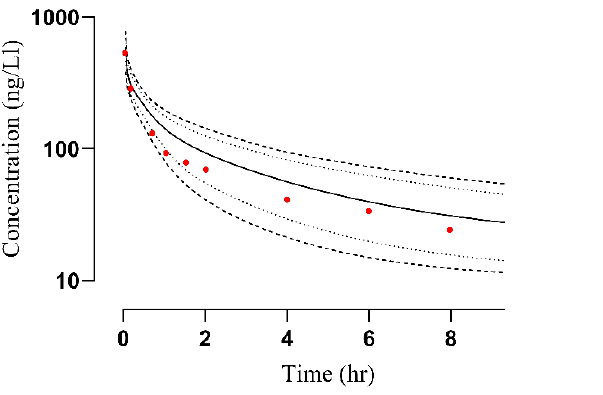
Figure 6. Comparison of observed and predicted plasma concentration versus time profile in renal failure subjects after IV [27] administered at a dose of 1 mg/kg. The solid line [―] indicates the arithmetic mean the dashed line [- - - -] maximum and minimum, the dotted line [....] 5th–95th percentile, red dots indicate observed data and solid line indicated predicted data.